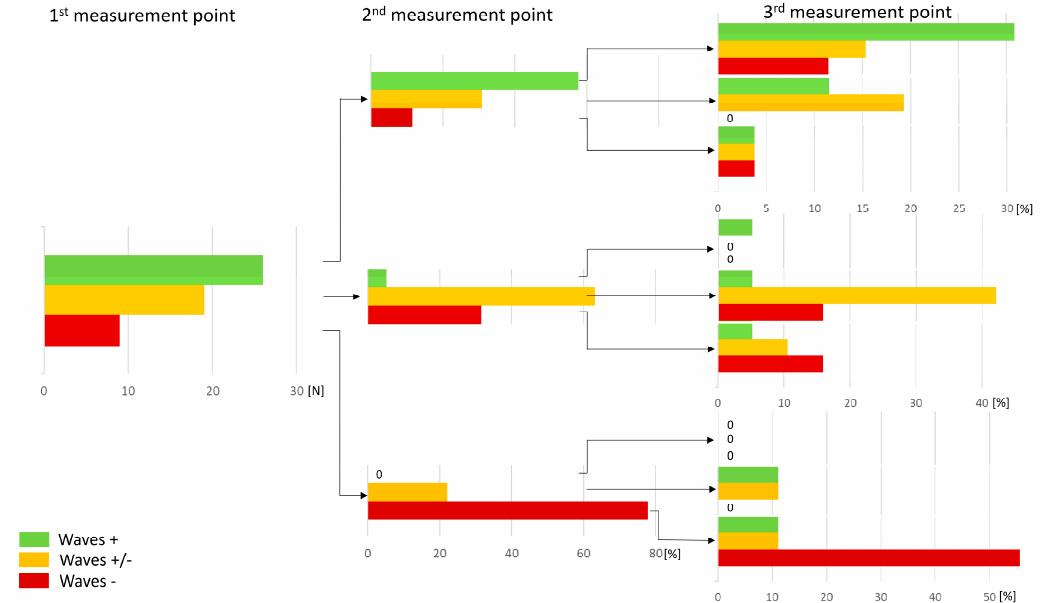
Figure 7. Visualization of pleural pressure curve pulsation during the procedure.